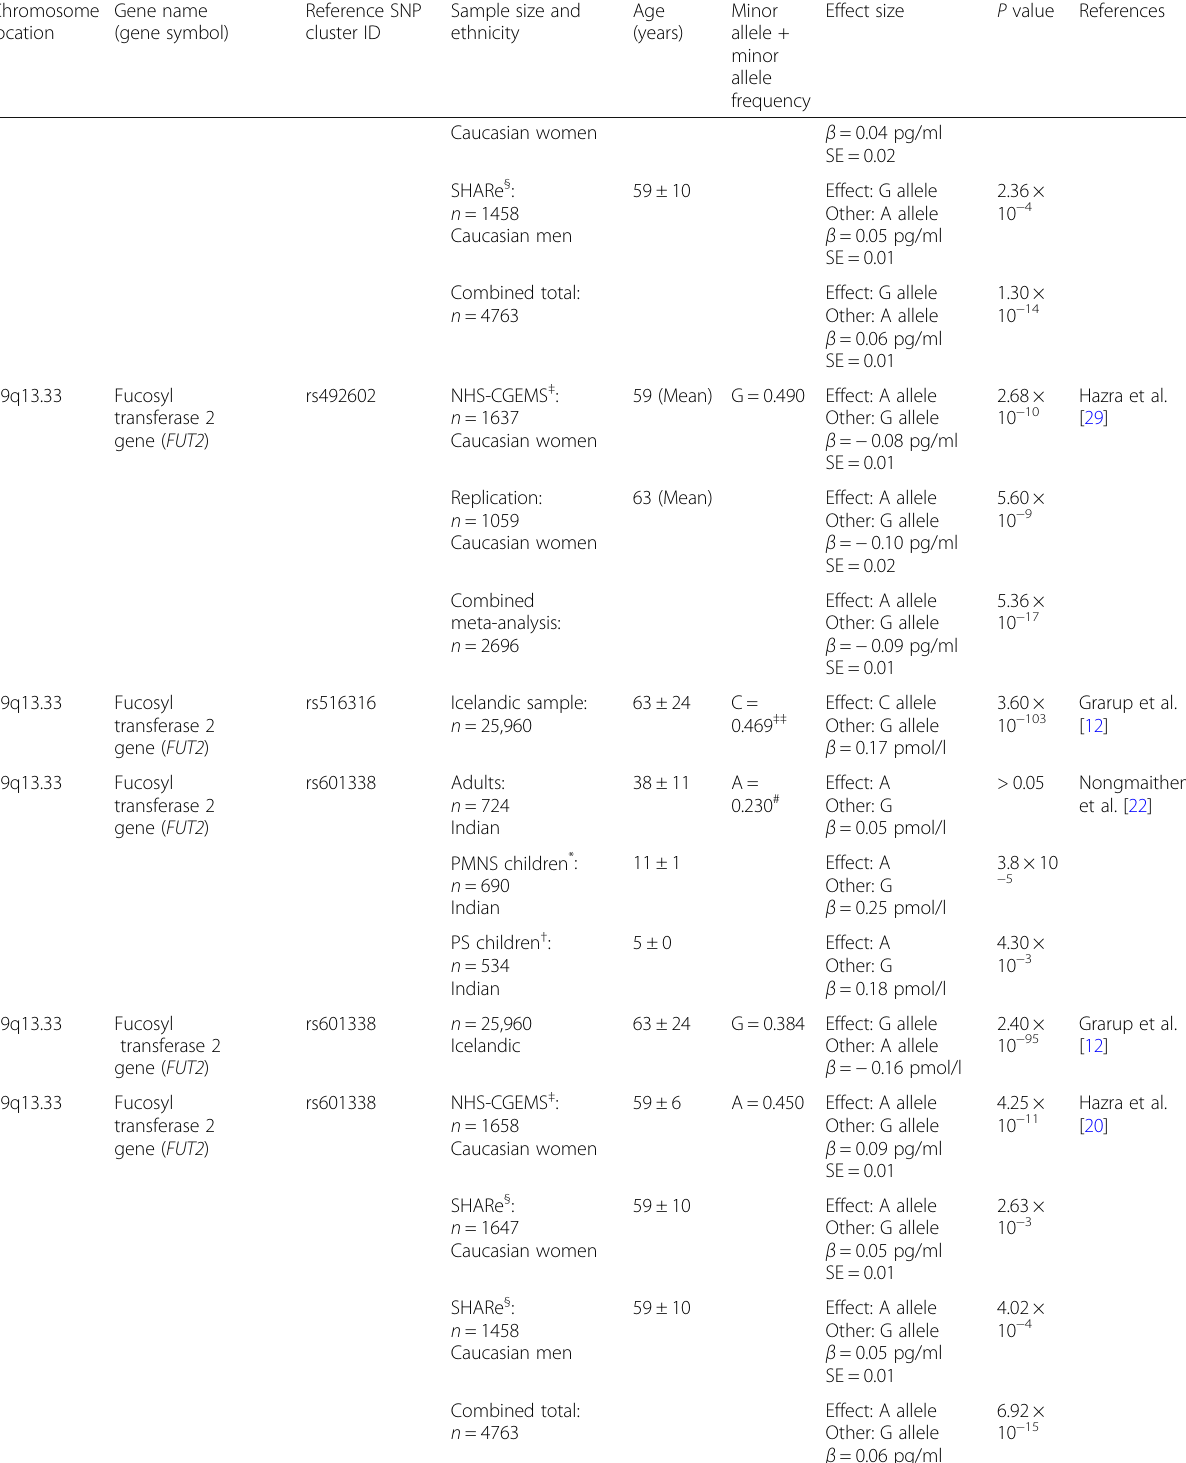
Table 1 Genome-wide association studies showing the association of SNPs with vitamin B12 concentrations. Genome-wide association studies testing the association between SNPs and vitamin B12 concentrations. The chromosome location, gene name, reference SNP cluster ID, sample size and ethnicity, mean age, observed frequency of the minor allele in the population, effect size and P value are shown in the table. The order of SNPs reflects the order of the chromosome location